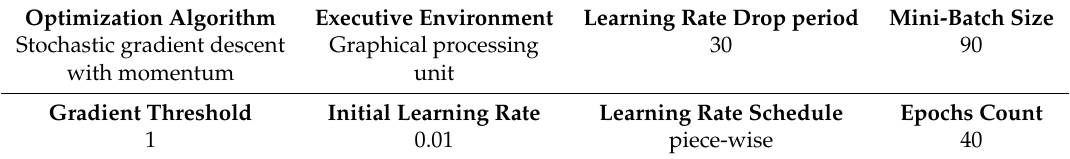
Table 1. Optimal hyperparameters for